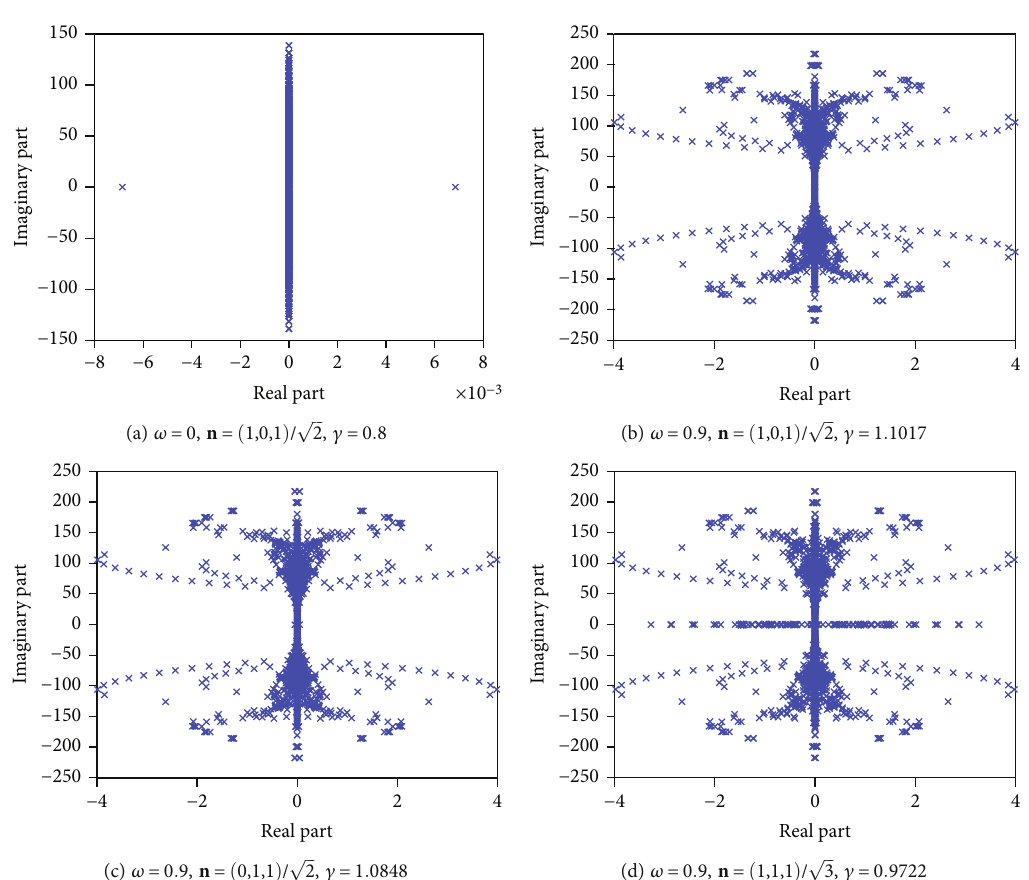
Figure 5: The discrete eigenvalues distribution of (45) for quasi-2D (rotating) dipolar BEC, where V ffiffiffi p / 5 , β = 500 , and λ = γβ